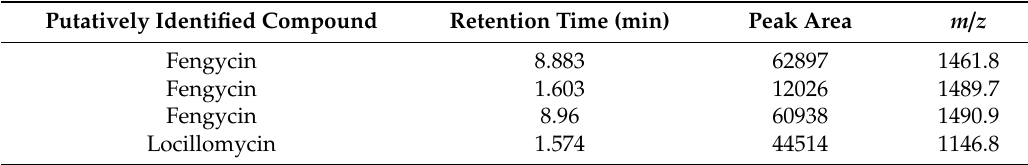
Table 4. Antimicrobial compounds putatively identified by the HPLC-MS (high pressure liquid chromatography–mass spectrometry) in the supernatant of B. velezensis IP22 cultivation broth.